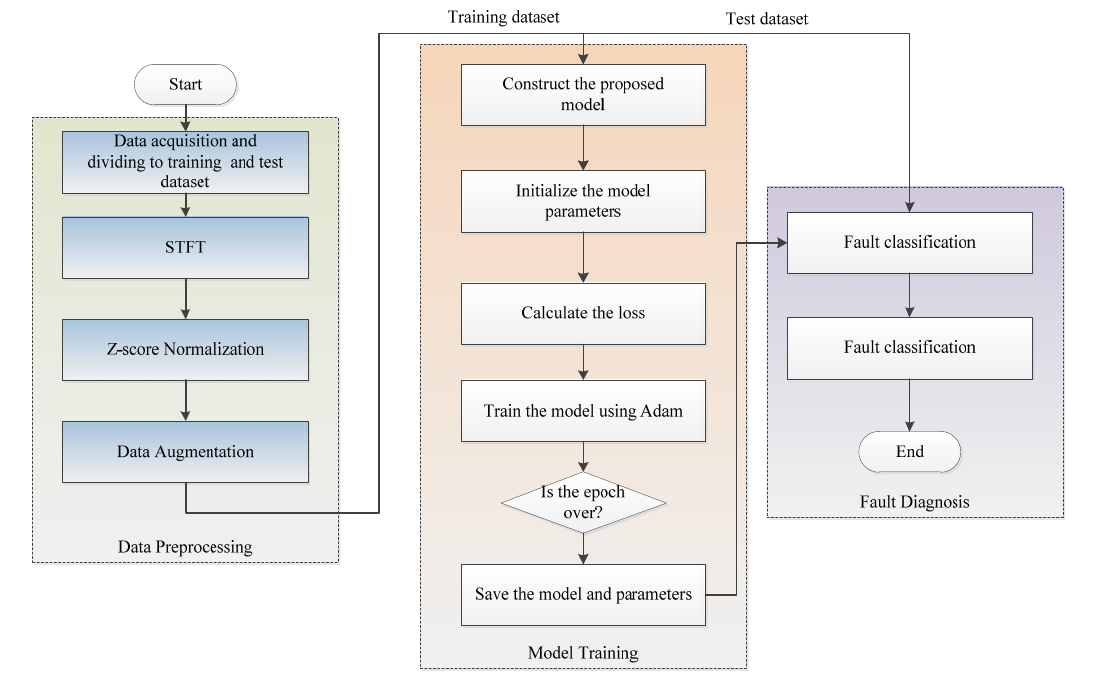
Figure 8. The flow chart of proposed model.